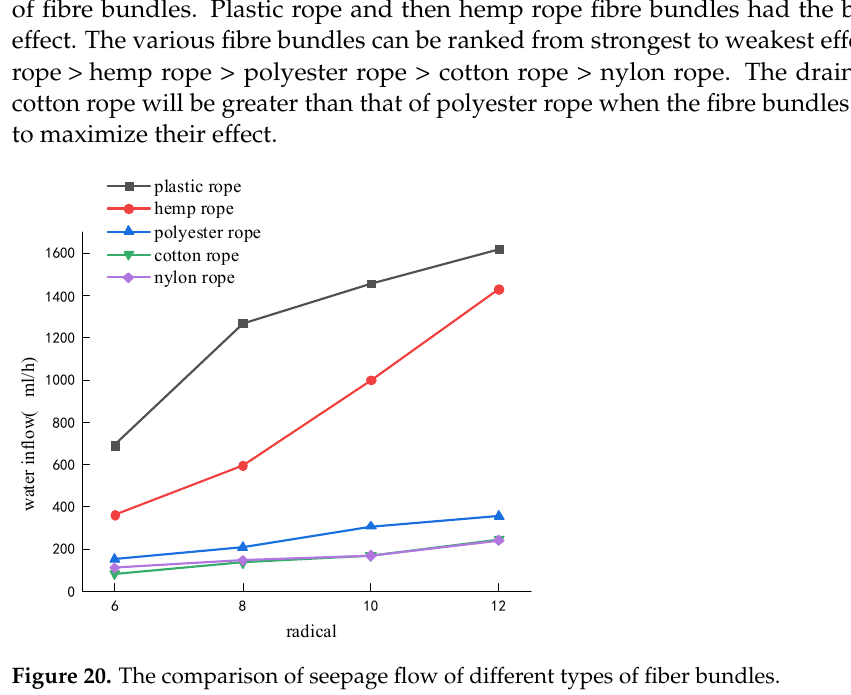
Figure 20. The comparison of seepage flow of different types of fiber